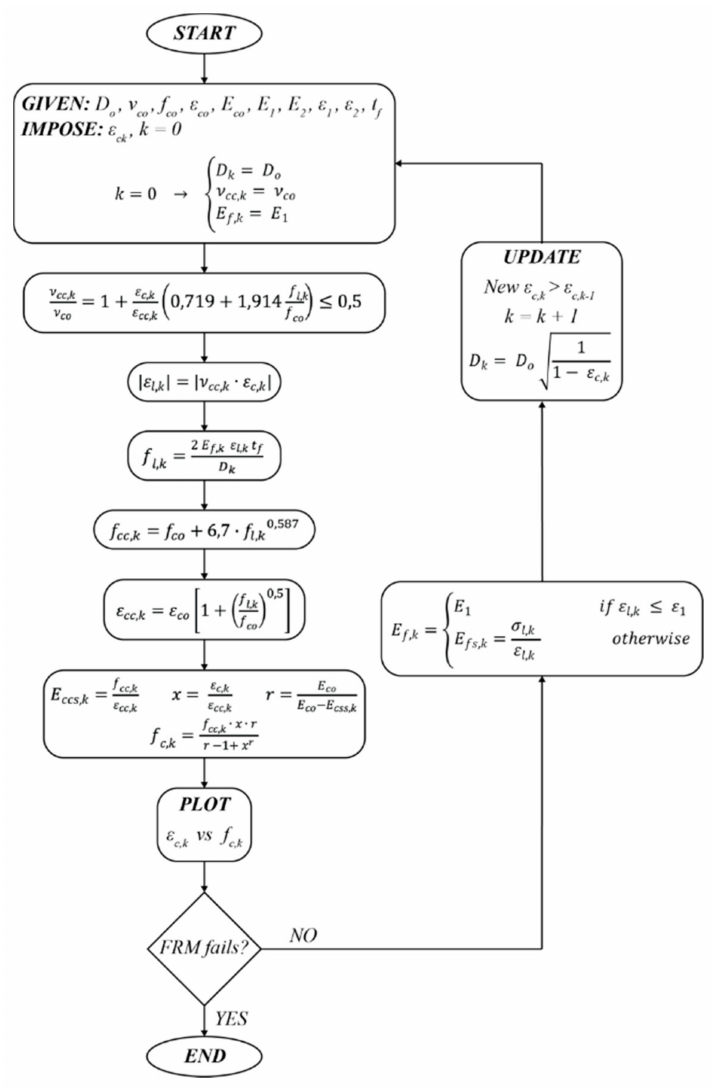
Figure 9. Flow-chart of the adopted analysis-oriented model (AOM). FRM, fabric reinforced mortar